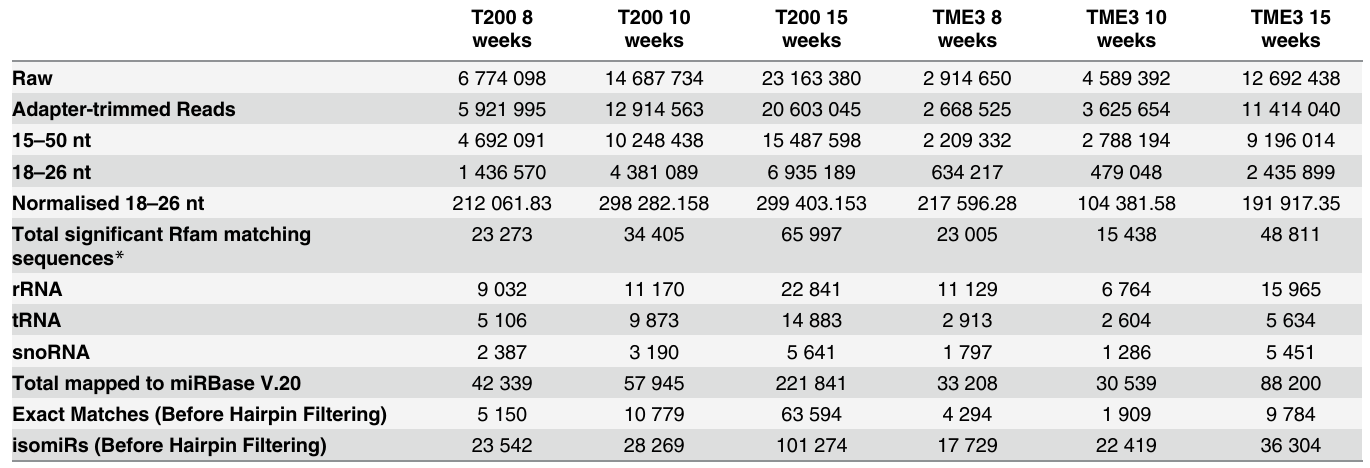
Table 1. Summary of small RNA sequencing data analysis.